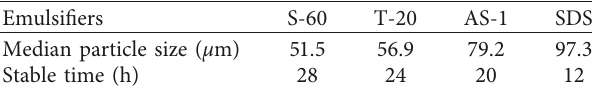
Table 5: Influence of the emulsifier on particle size and stability